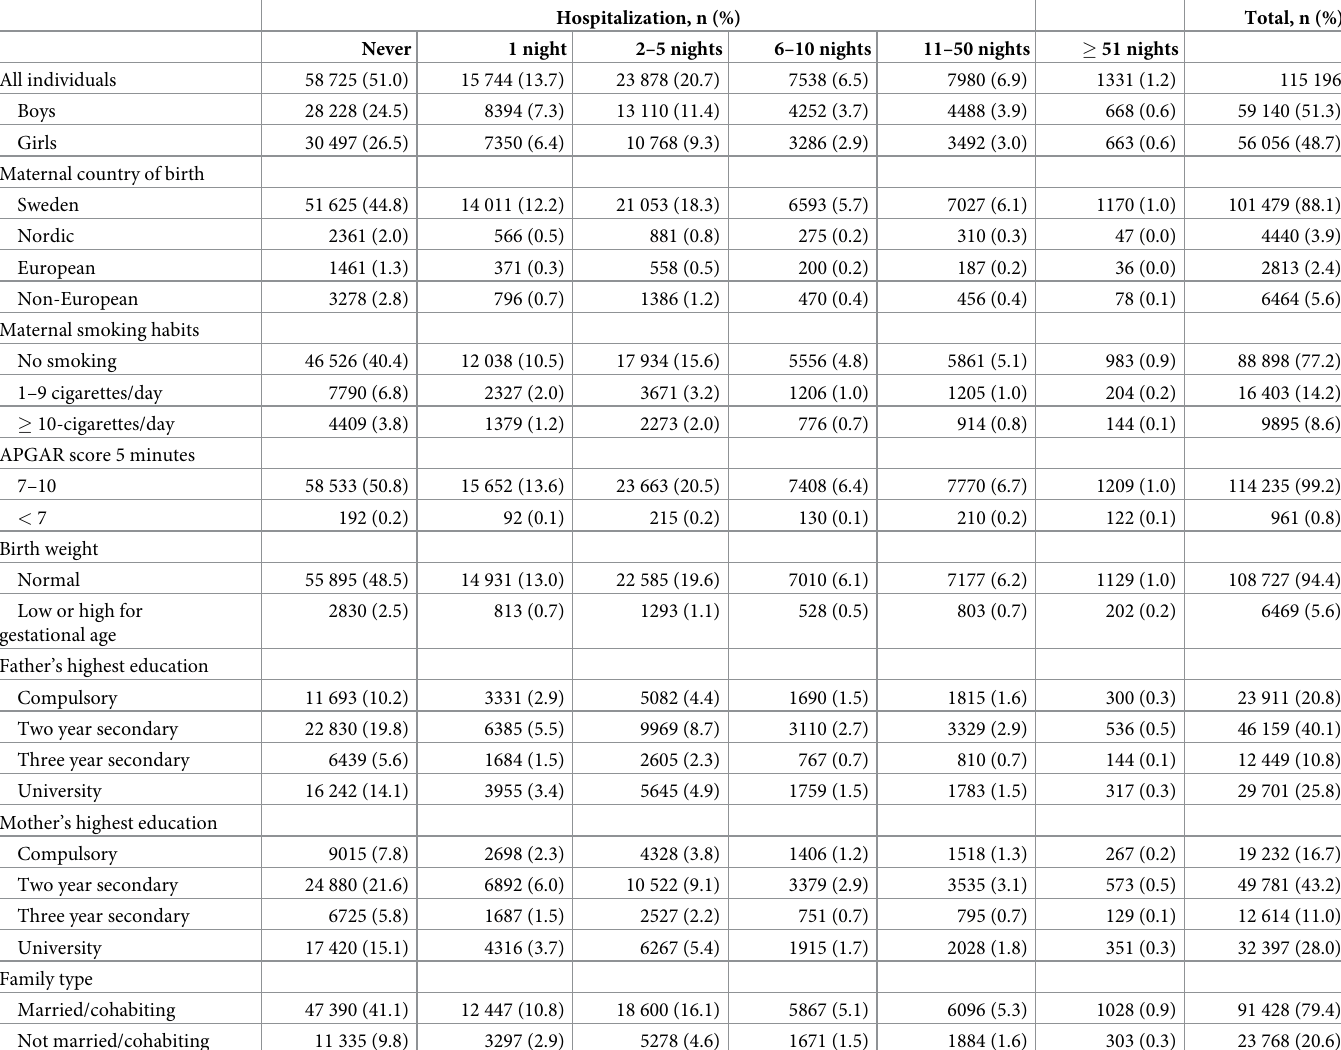
Table 1. The study population and background variables stratified by hospitalization